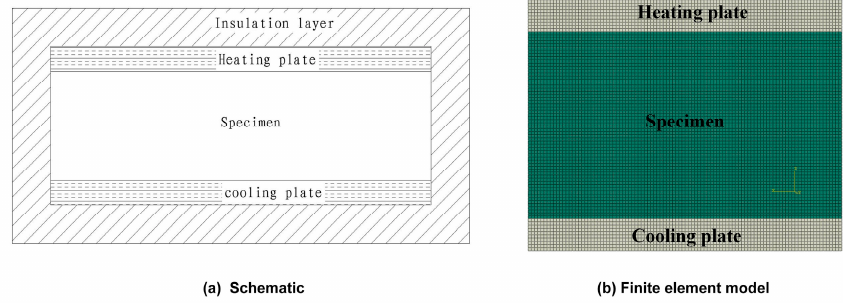
Figure 9. Steady-state plate method: ( a ) schematic diagram; ( b ) numerical model.